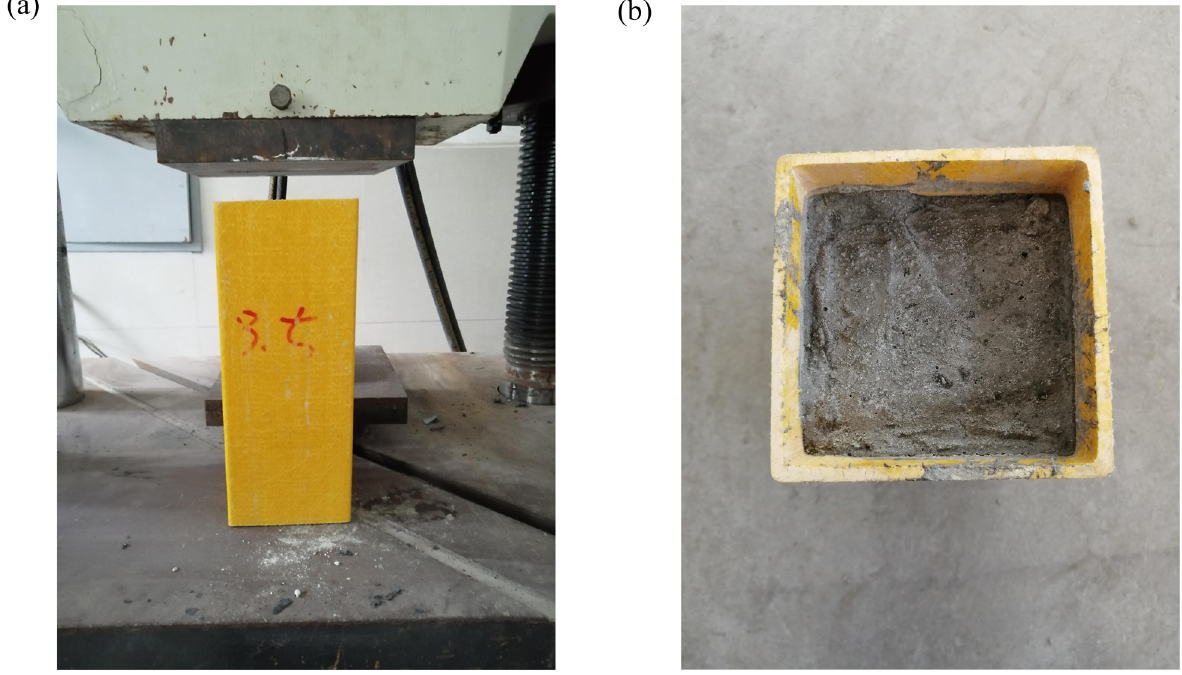
Figure 1: Pictures of the specimen: ( a ) elevation view and ( b ) overhead